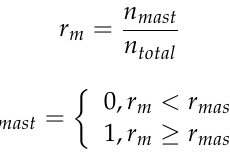
is obscured; ( b ) The scene 1 where the object is obscured; ( c ) The scene 2 where the object is obscured; ( d ) The scene 3 where the object is obscured.